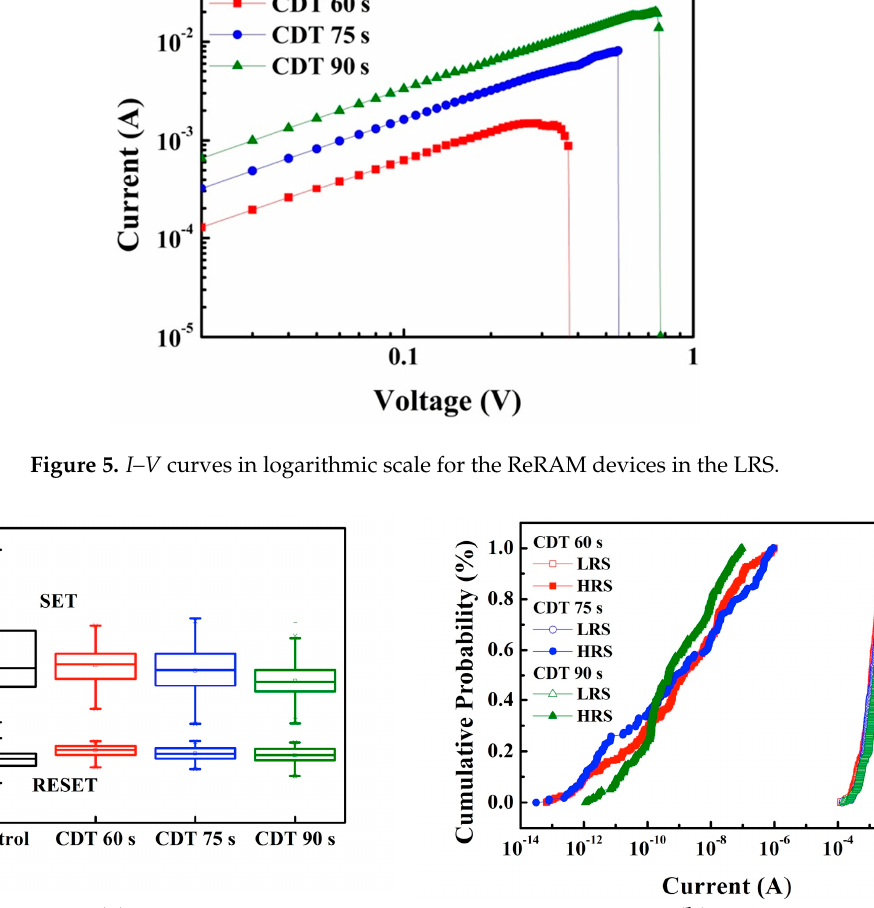
Figure 6. ( a ) Electric field distributions and ( b ) current distributions of the control and Cu-CDT ReRAM devices in the low resistance state (LRS) and high resistance state (HRS). devices in the low resistance state (LRS) and high resistance state